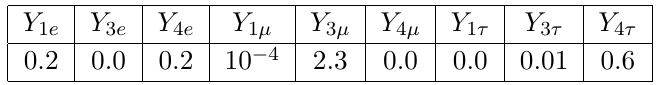
Table 6 . Values of the Yukawa couplings for the evaluation of Z → ‘ i ‘ j